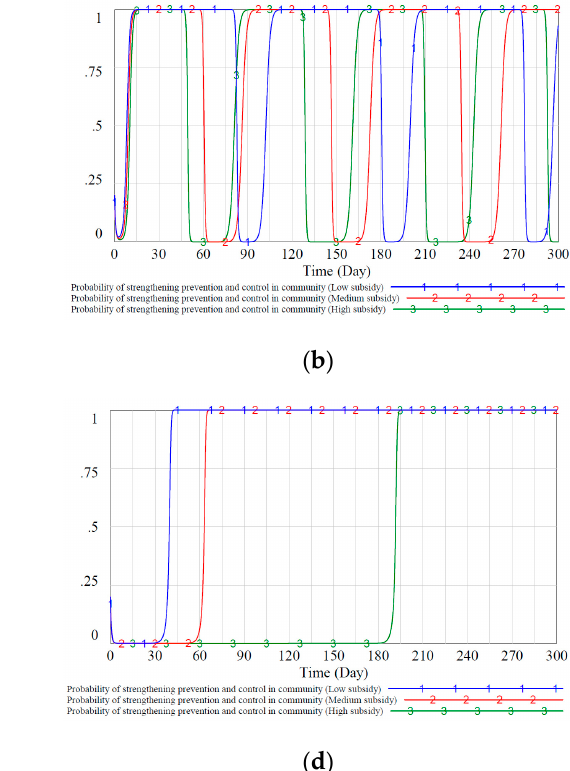
Figure 5. The impact of different initial strategy combinations on the evolutionary stable equilibrium strategy under the dynamic reward and punishment mechanism. ( a ): initial value strategy combinations